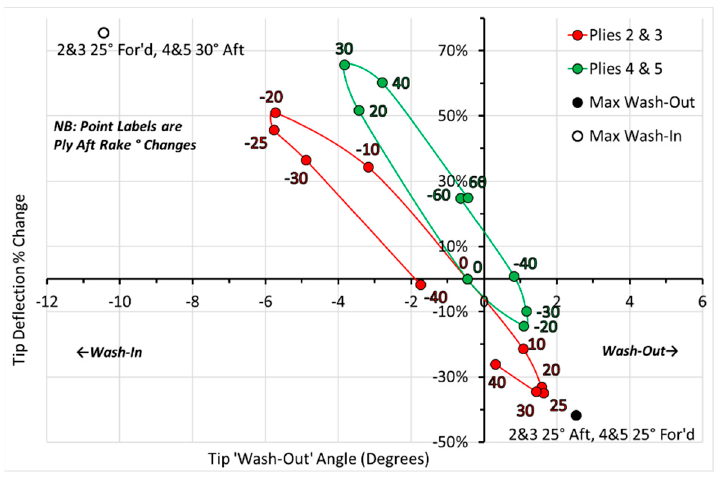
Figure 23. Two-way FSI variation of tip deflection and twist with ply rotation angles.